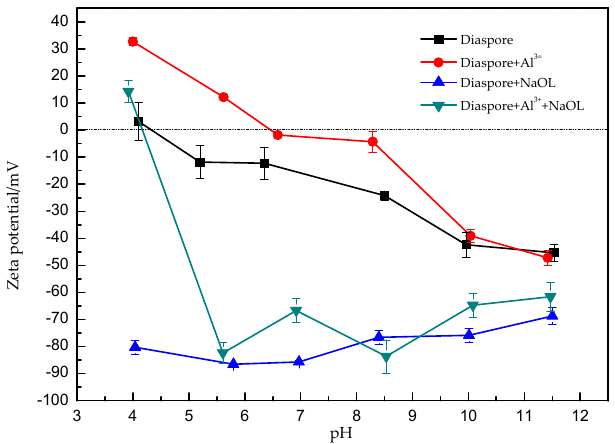
Figure 6. Zeta potential of diaspore under four different treatments (Al 3+ : 1 × 10 − 4 mol/L; NaOL: 5 × 10 − 4 mol/L).